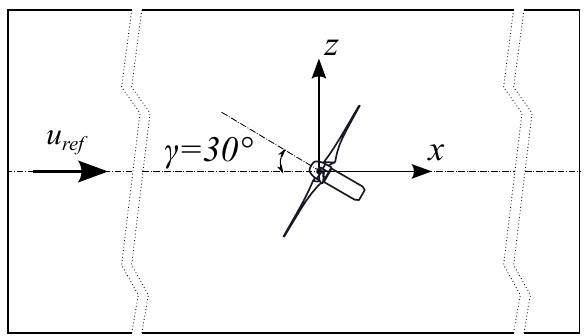
Figure 3. Reference coordinate system in the wind tunnel and def- inition of positive yaw angle γ , top